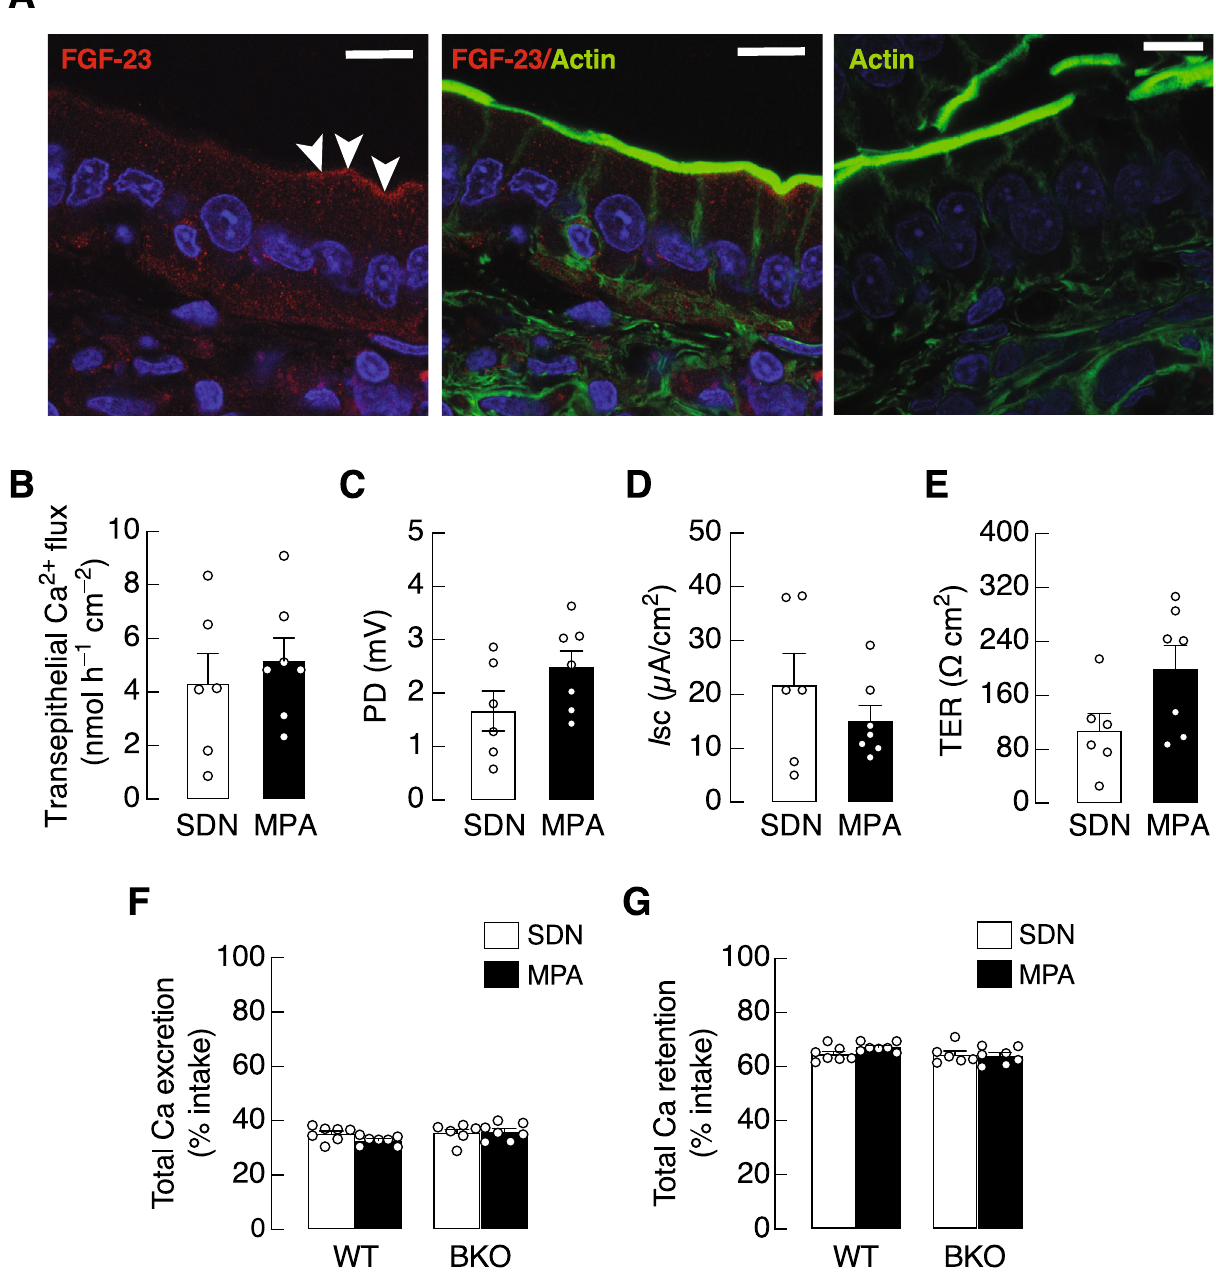
Figure 4. ( A ) Representative photomicrographs of FGF-23 protein expression in duodenal epithelium obtained from confocal laser scanning microscope. Positive red signals of FGF-23 (left and middle panels) are distributed in the cytoplasm especially in the vicinity to the basolateral and apical membrane (arrowhead). Negative control image is presented (right panel). A representative image of actin staining (right panel) is from the same animal (different tissue section), and shows no red signal artifact. Green signal represents F-actin, blue signal represents nucleus (scale bar, 10 µm). ( B – E ) Duodenal calcium flux and epithelial electrical parameters, i.e., transepithelial potential difference (PD), short-circuit current ( I sc ), and transepithelial resistance (TER) of the duodenal tissues from β-globin knockout (BKO) mice subjected to mild-intensity physical activity (MPA) training or sedentary (SDN) group. Calcium balance study, i.e., total Ca excretion ( F ), and retention ( G ) were determined by metabolic cage study and FAAS. Values are means ± SE (n =